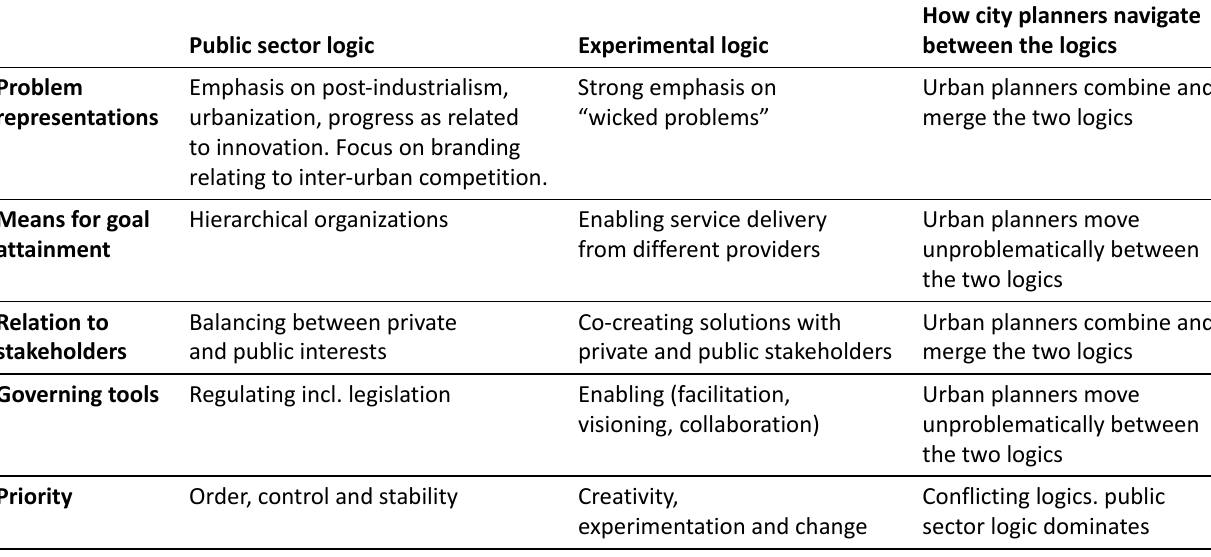
Table 2. Public sector and experimental logics in three examples of testbed